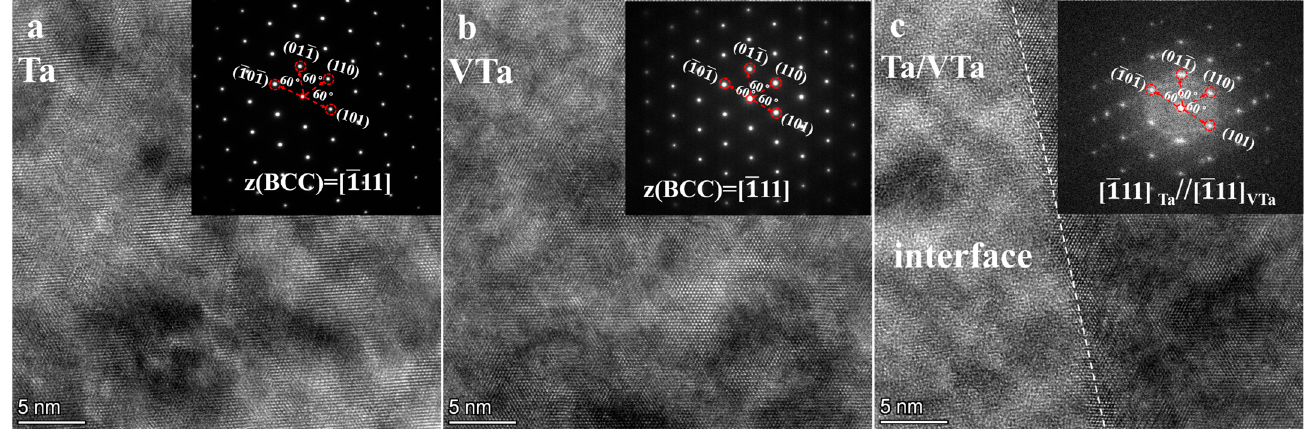
Figure 19. Orientation relationships between HR-TEM image and interface in W/V/TiN/Ta compo- site joined at 1400 °C: ( a ) Ta; ( b ) VTa; ( c ) Ta–VTa